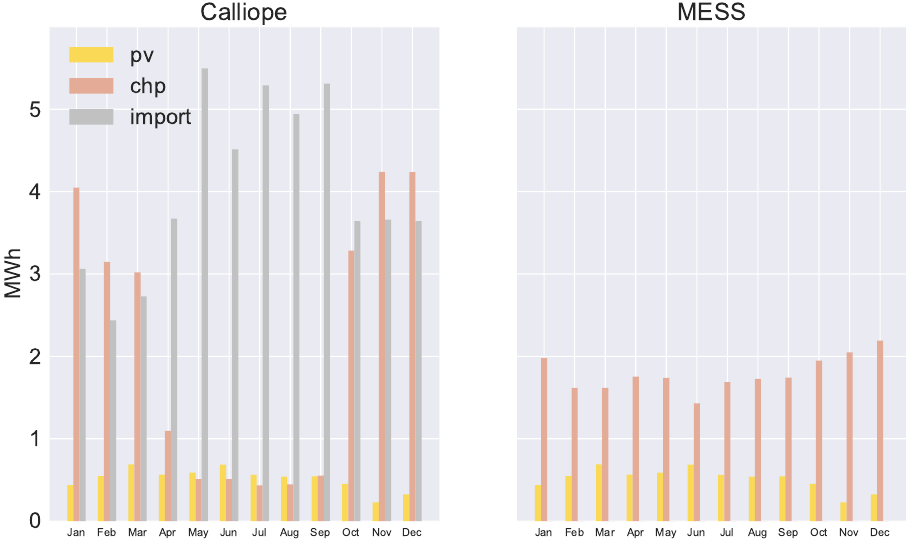
Figure 7. Monthly electricity production per technology source: Location X1—Calliope and MESS comparison.